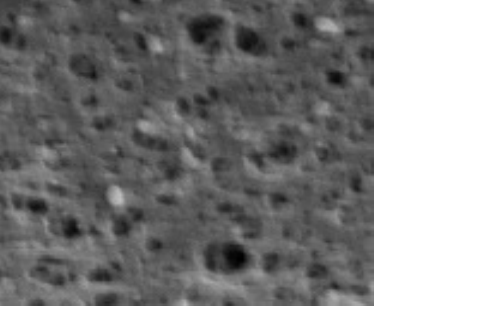
Figure 3 . Supporter Ⅰ Figure 4 . Surpporter Ⅱ Table 1. The immobilization results of β -galactosidase on the supporter Ⅰ and the supporter Ⅱ Type of